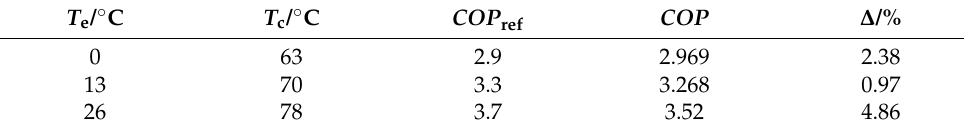
Table 2. Verification of compression cycle compared to reference [28].